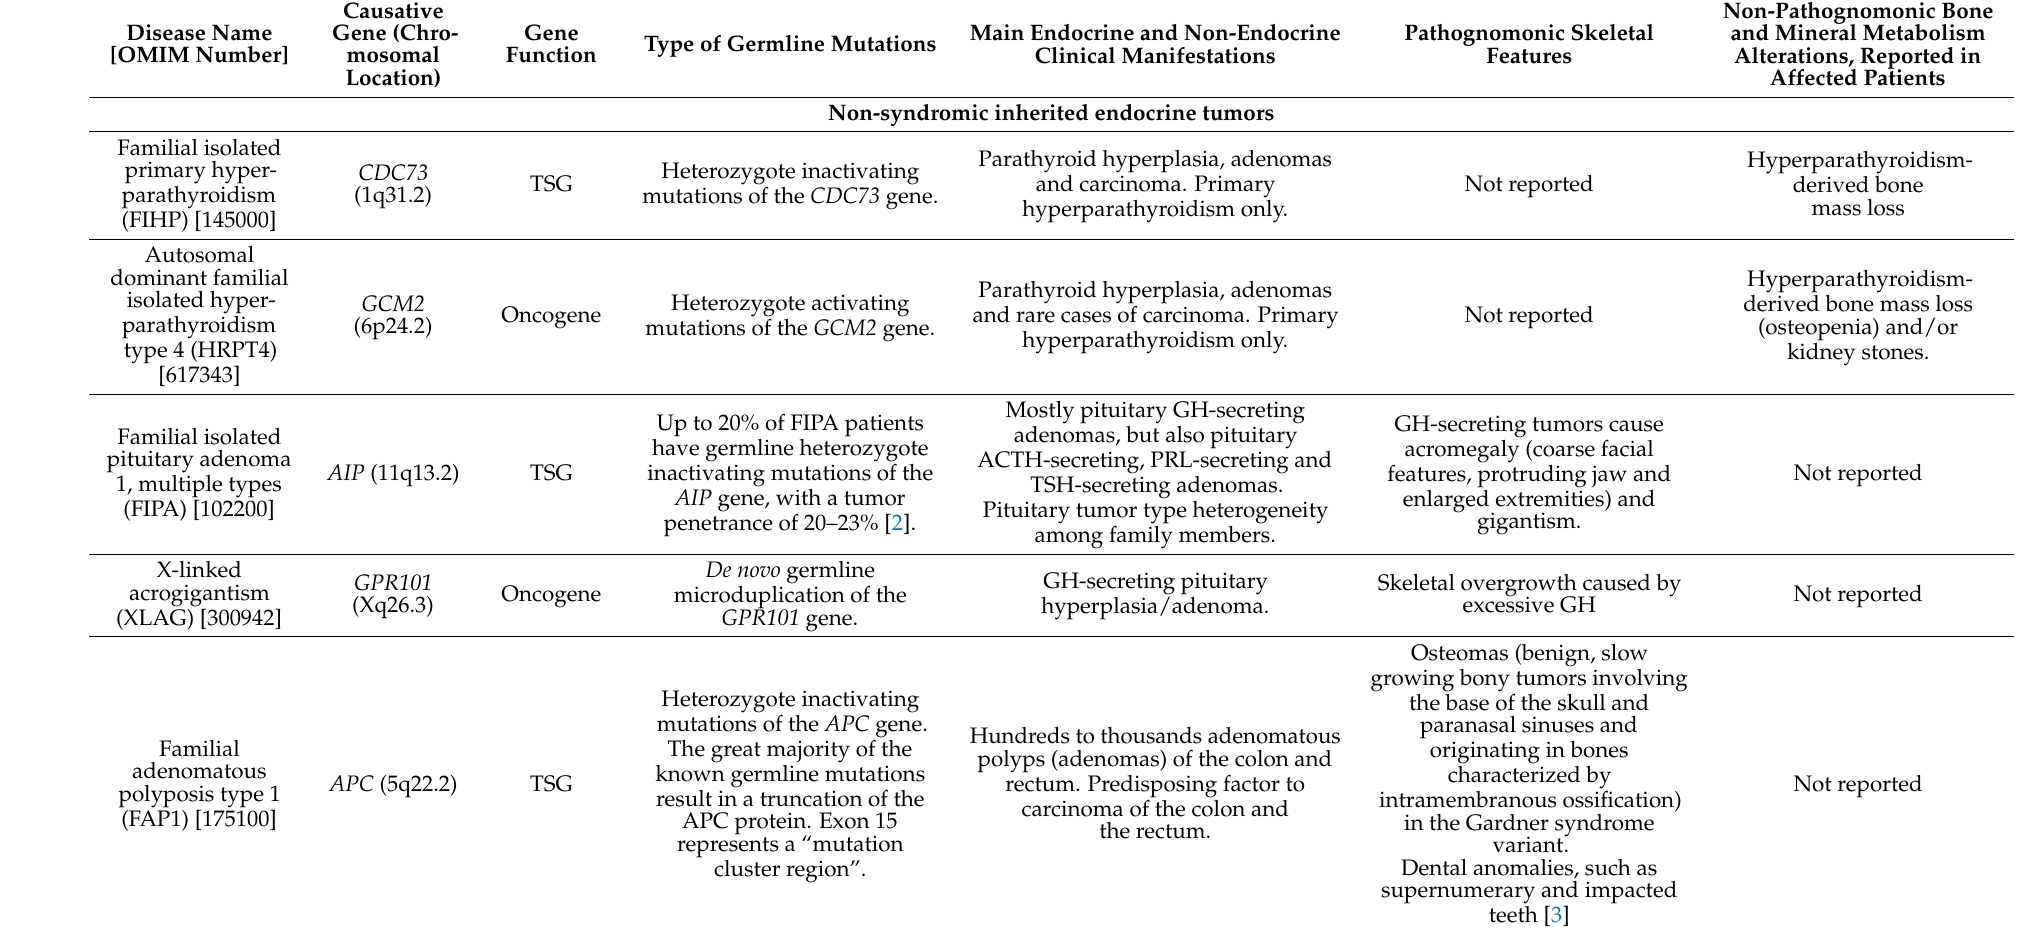
Table 1. Causative genes, main endocrine and non-endocrine clinical manifestations and skeletal features in inherited endocrine